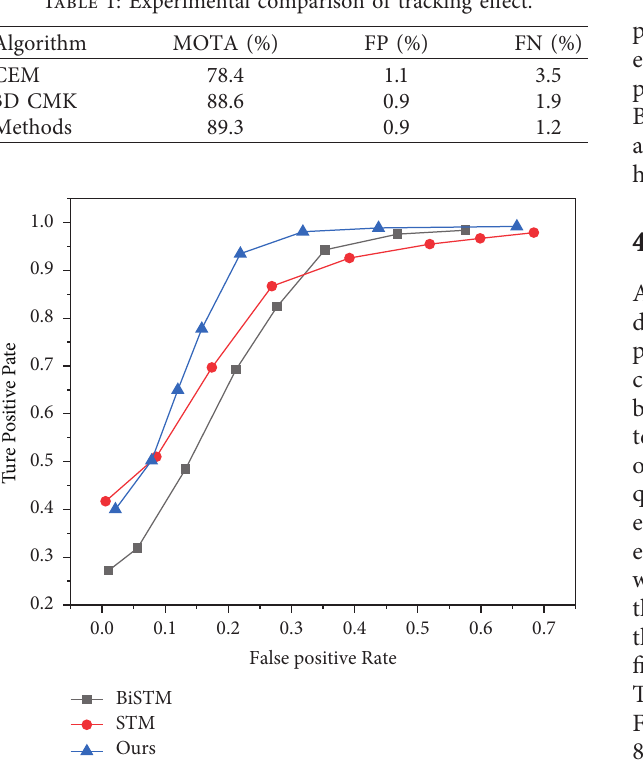
Figure 3: ROC curve of accident